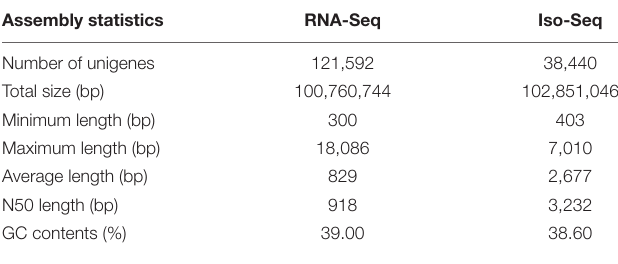
TABLE 1 | Assembly statistics of the S. occidentalis transcriptome by RNA-seq and Iso-Seq. Assembly